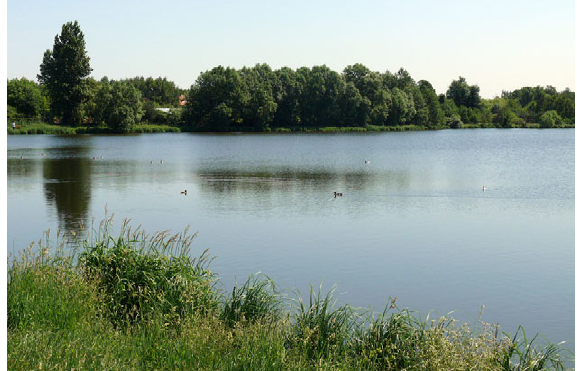
Fig. 5. Komorów Reservoir – local favourite place of walks and angling. Photo by M. Górska-Zabielska